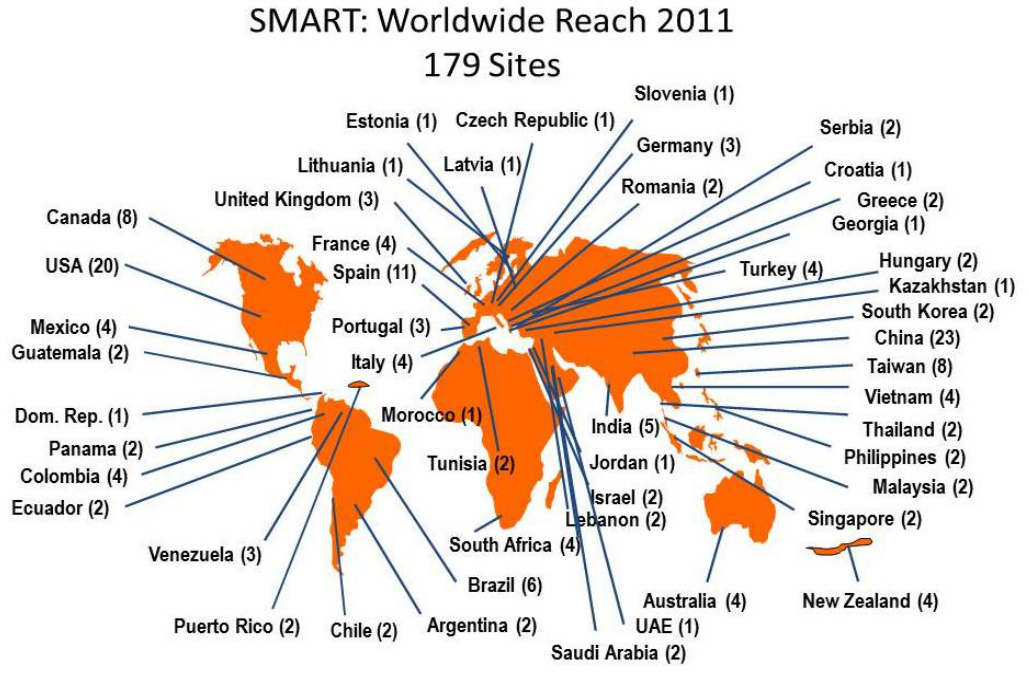
Figure 1. Map indicating SMART sites as participating in